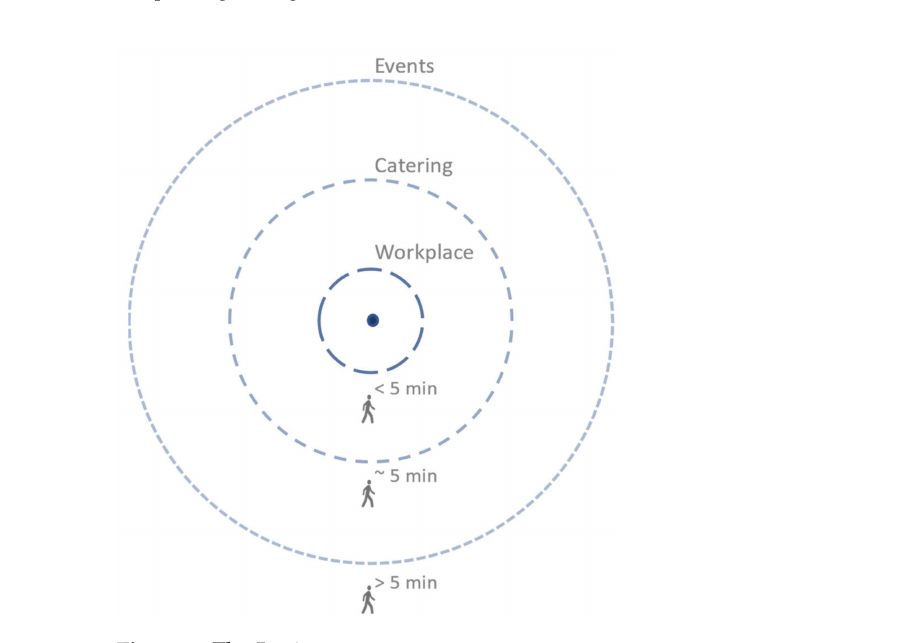
Figure 5. The 5-minute